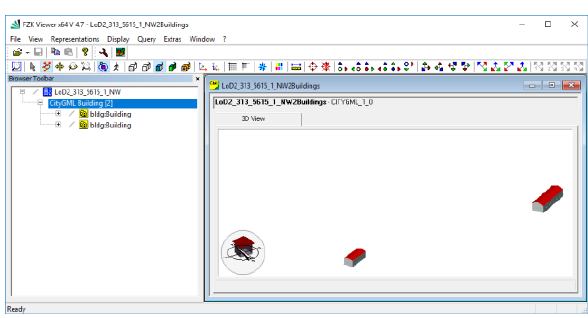
Figure 1. Two connected buildings (Dataset A)